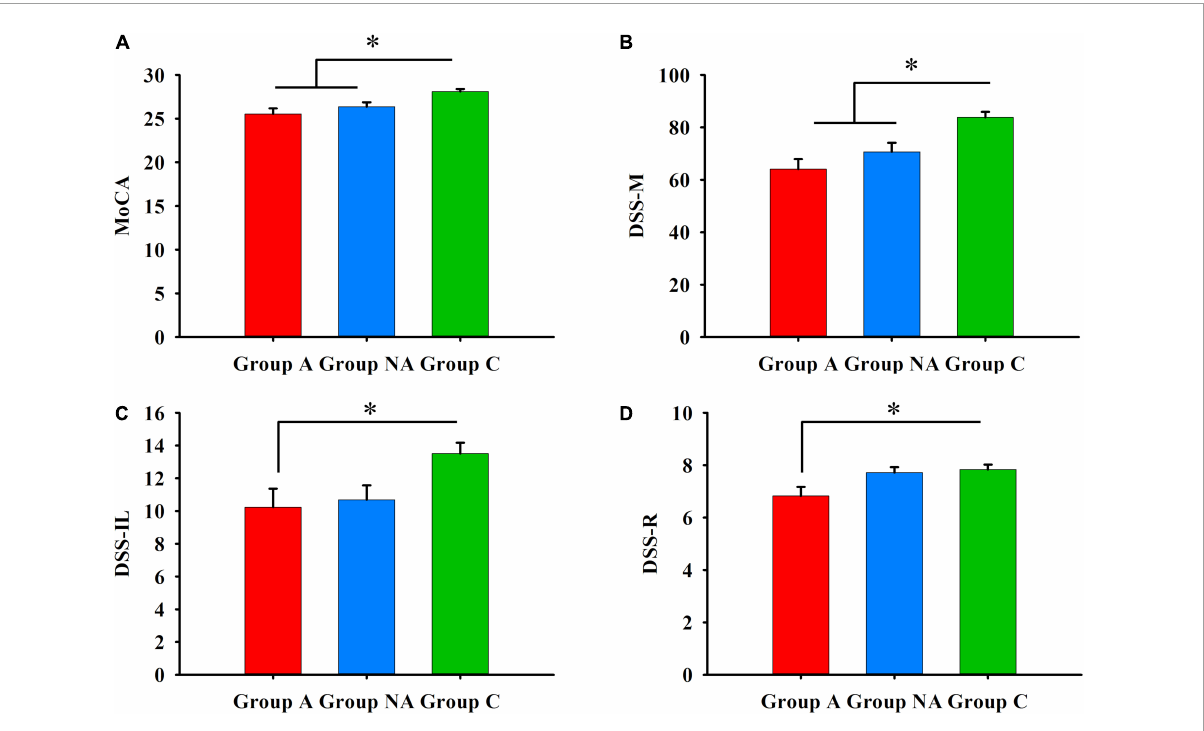
FIGURE4 (A) General cognition. Differences in MoCA among A, NA, and C groups (Kruskal–Wallis test, Bonferroni correction. ∗ P s ≤ 0.017). (B) Psychomotor speed. Differences in DSS-M among A, NA, and C groups (Kruskal–Wallis test, Bonferroni correction. ∗ P s ≤ 0.015). (C) Incidental learning. Differences in DSS-IL among group A, group NA, and group C (Kruskal–Wallis test, Bonferroni correction. ∗ P = 0.043). (D) Incidental learning. Differences in DSS-R among A, NA, and C groups (Kruskal–Wallis test, Bonferroni correction. ∗ P =